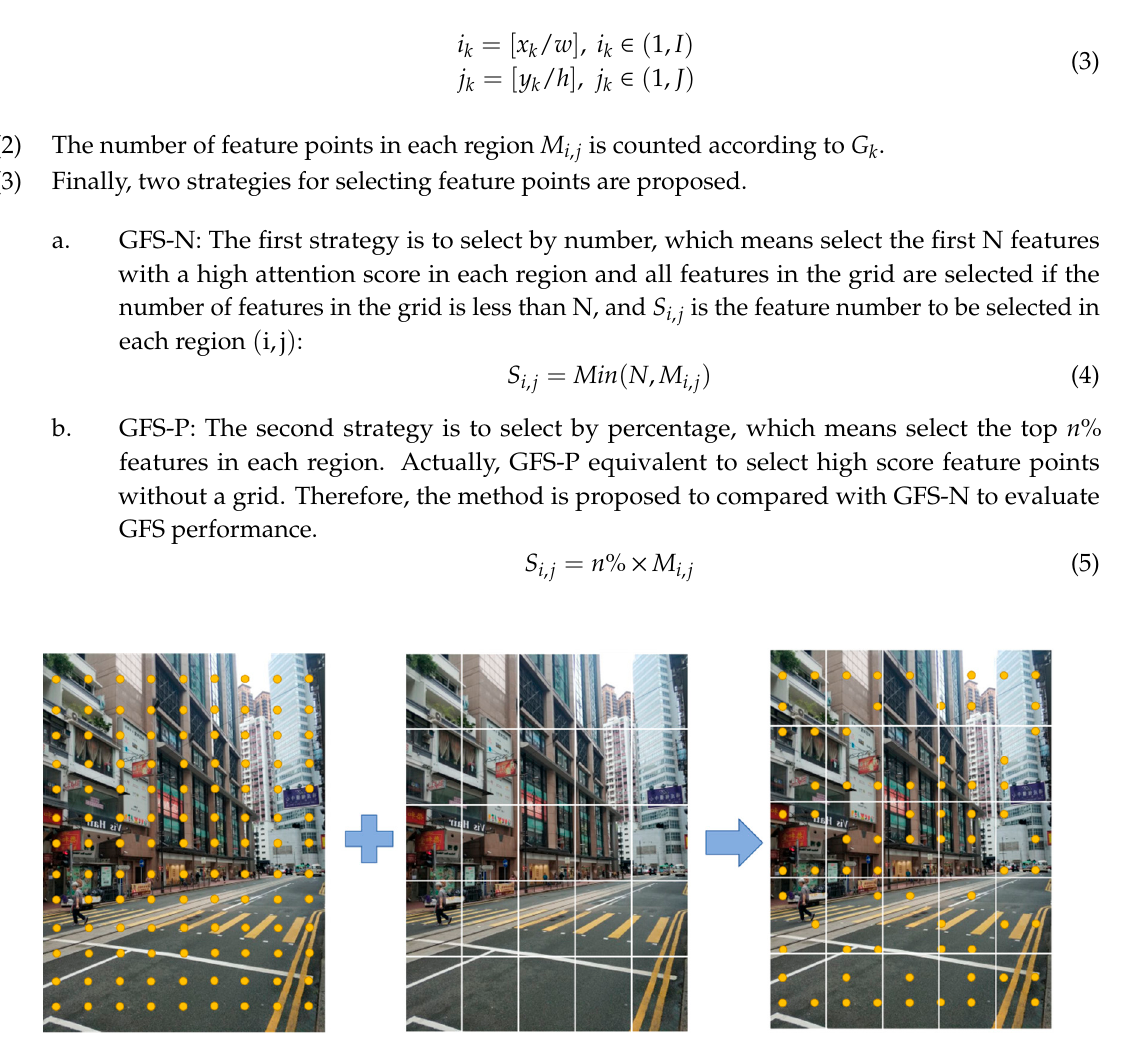
Figure 4. The grid feature ‐ point selection method. Since a picture has hundreds of feature points, the figure is simplified. The yellow points represent the location of the feature points, and the white grid divides the image into multiple regions. After performing grid feature ‐ point selection method (GFS), the number of feature points is reduced.